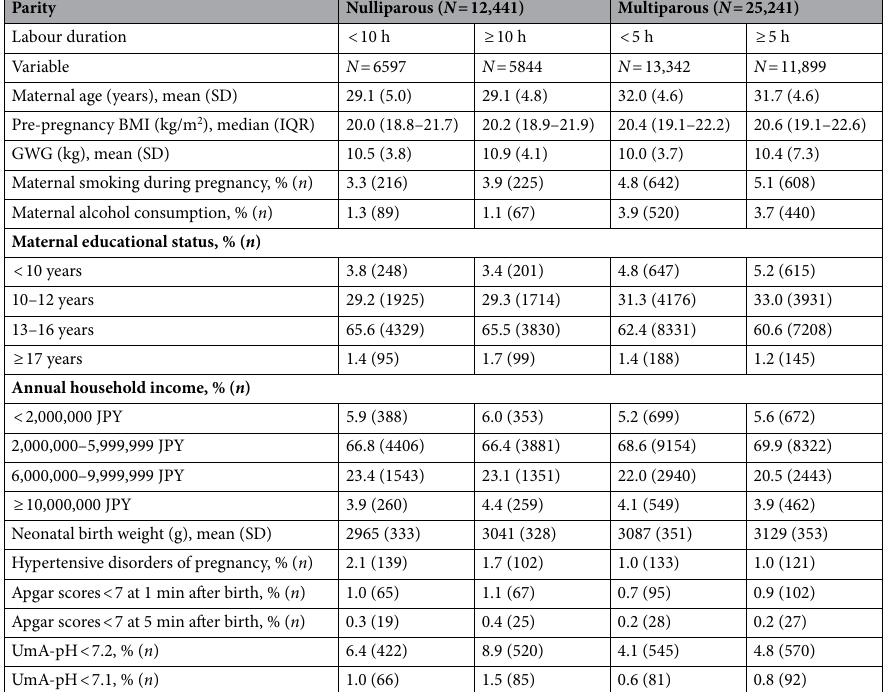
Table 1. Maternal characteristics and obstetric outcomes according to labour duration status after stratification by parity. BMI; body mass index, GWG; gestational weight gain, IQR, interquartile range; JPY, Japanese yen; SD, standard deviation; UmA, umbilical artery.